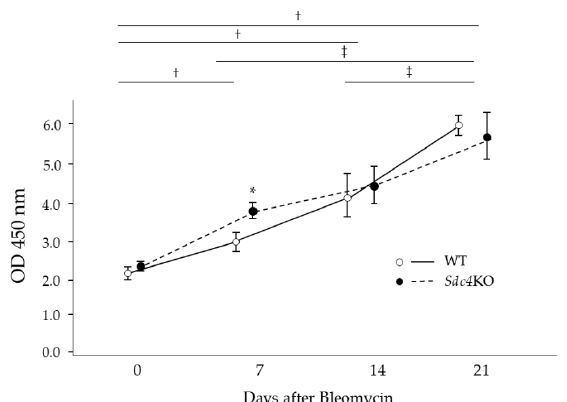
Figure 6. Levels of phosphorylated Smad3 in lung tissues. Levels of phosphorylated Smad3 in lung